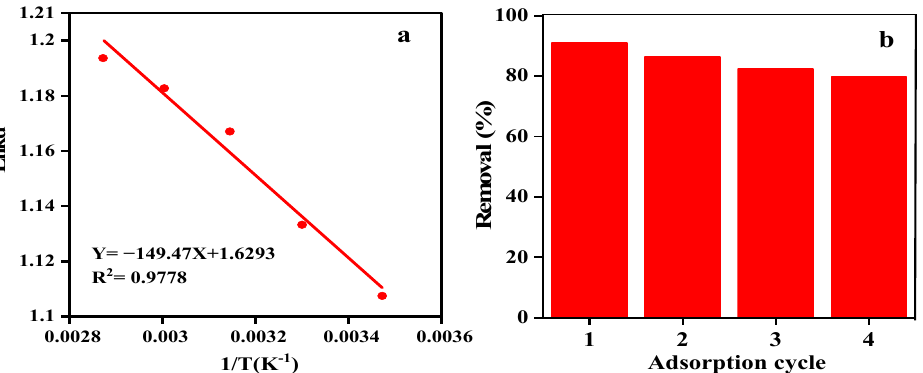
Figure 8. ( a ) The Van’t Hoff plot describing the thermodynamic behavior of SMT adsorption on the γ -Fe 2 O 3 /MWCNTs/Ag NC particles, and ( b ) reusability of γ -Fe 2 O 3 /MWCNTs/Ag NC adsorbent after 4 cycles.